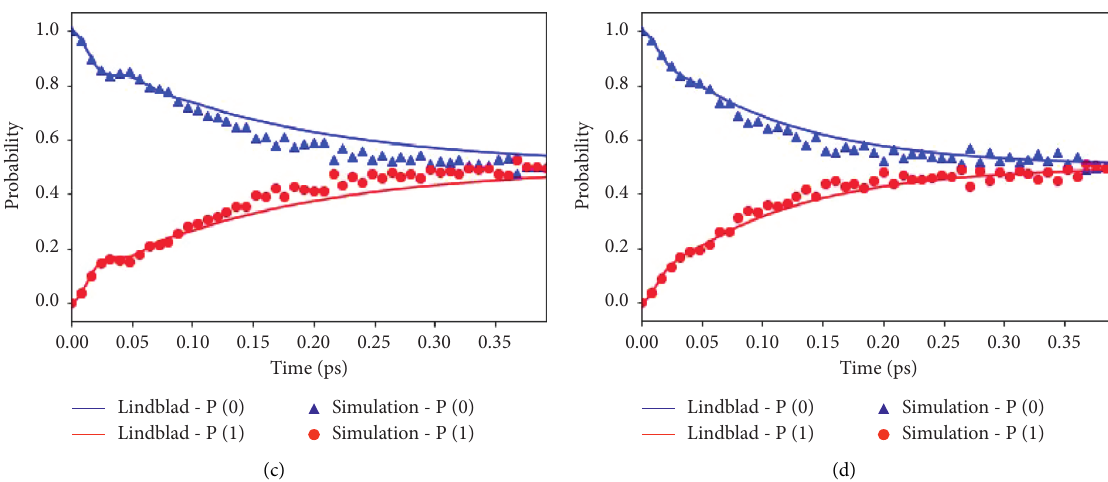
Figure 8: Evolution dynamics of the system with decoherence obtained by employing the quantum algorithm for the nonresonant system: simulation results (points) and theory (lines). (a) g � 1000 cm − 1 ; c deph � 2.3THz. (b) g � 300 cm − 1 ; c deph � 10THz. (c) g � 700 cm − 1